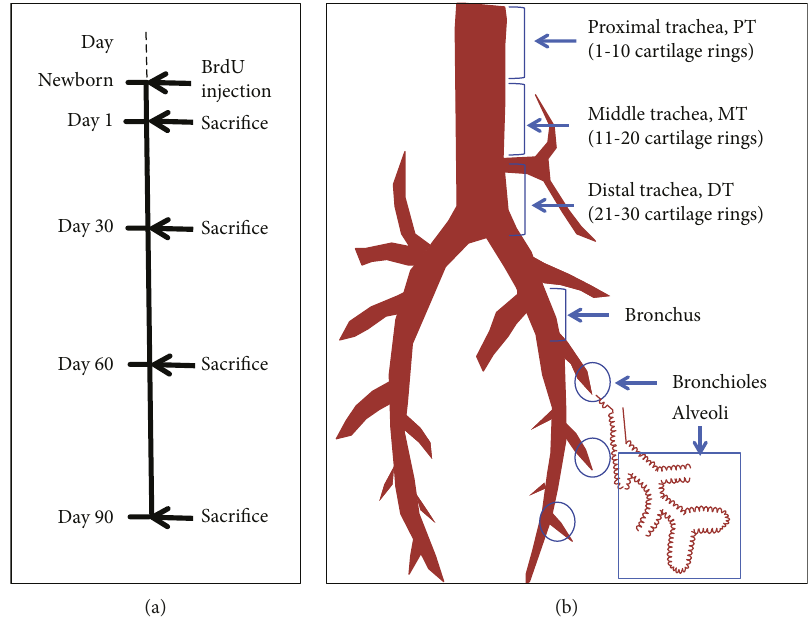
Figure 1: Timeline and tissues collected for analysis. (a) Timeline for postnatal maturation experiments of pig after the pulse of BrdU. (b) Illustration of the anatomic segments of conducting airway tissues analyzed in this study. PT, proximal trachea (1-10 cartilage rings); MT, proximal trachea (11-20 cartilage rings); DT, distal trachea (DT, 21-30 cartilage